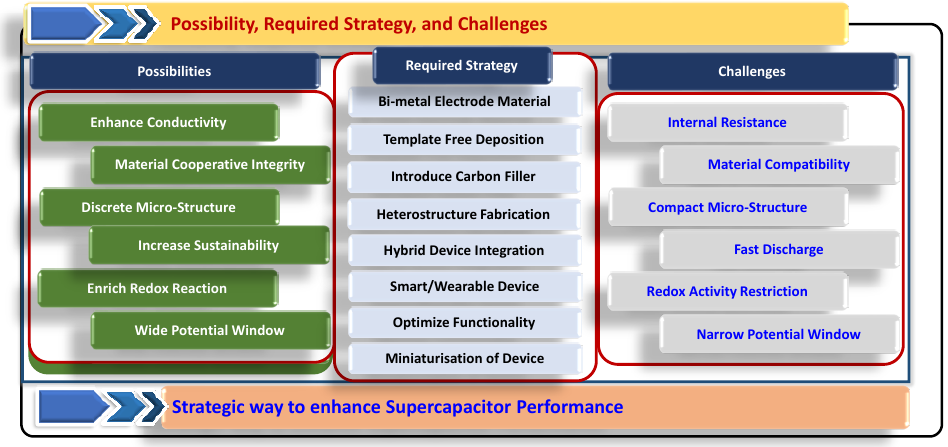
Figure 11. Tabularized list of possible supercapacitor enhancement strategies and challenges.